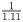
Effect of segregation distortion on genetic mapping.(a) When no selection is applied, two linkage groups representing simulated chromosome 1A and chromosome 6B are formed with perfect order of marker bins. (b) When a strong selection pressure of 11.11 is applied at locus 30 and 200 of 6B and 1A respectively, the recombination fractions between markers at these loci and surrounding markers are lowered, but not enough to disrupt clustering or ordering of the markers. (c) When a strong enough selection pressure of 11.105 is applied such that one of the loci has zero A genotypes, the recombination frequencies of markers under selection are low enough such that chromosomal fragments experiencing segregation distortion are concatenated into the same linkage group. White lines delineate linkage groups.